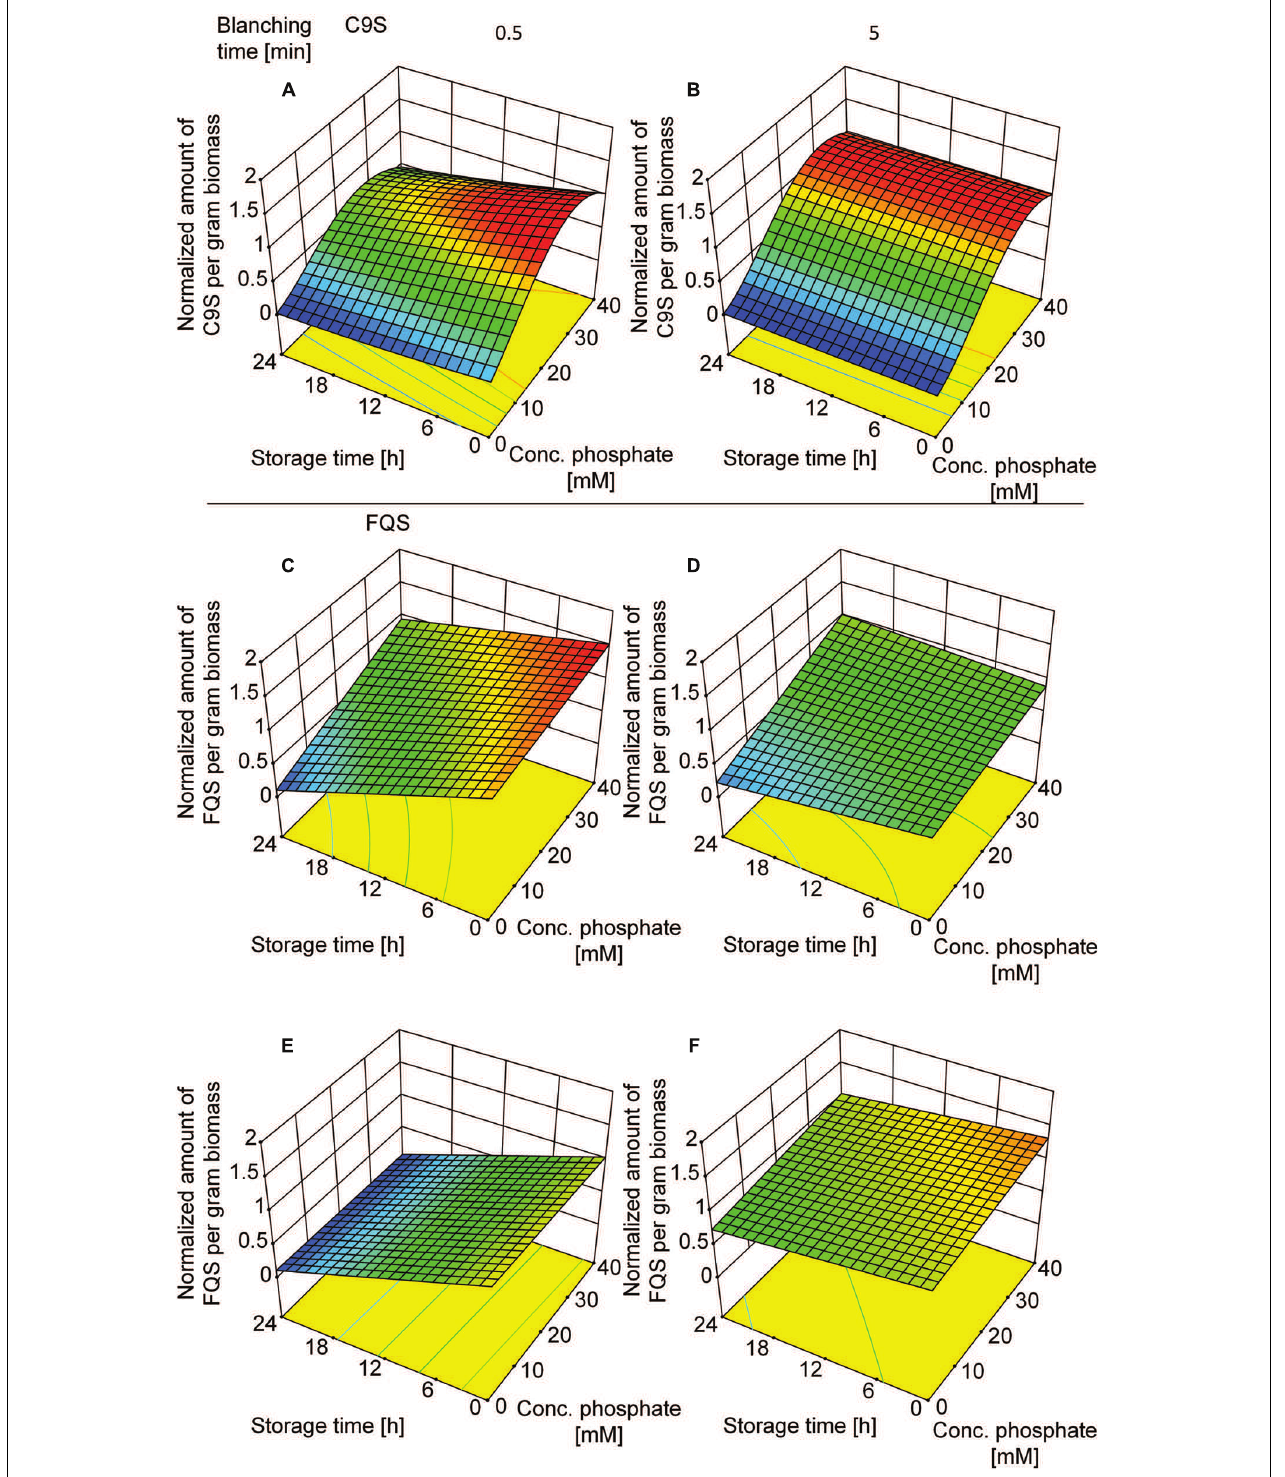
FIGURE 7 | Response surface models showing how the yields of C9S (A,B) and FQS (C–F) depend on phosphate concentration in the blanching buffer, incubation and storage times as well as buffer conductivity. A phosphate concentration of 30–40 mM resulted in the highest yields of C9S and an incubation time of more than 0.5 min was required for the C9S to concentration to remain constant over a 24 h incubation period at RT. The phosphate concentration did not have a relevant effect on the yield of FQS but incubation times exceeding 0.5 min were necessary to prevent product loss over the subsequent 24 h incubation period. Colors are used to indicate high (red) or low (blue) response values.